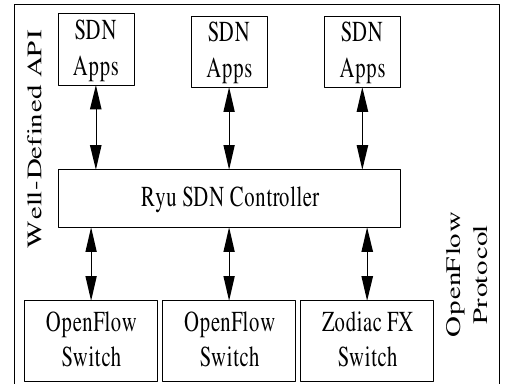
Figure 5. Ryu controller connection with Zodiac FX